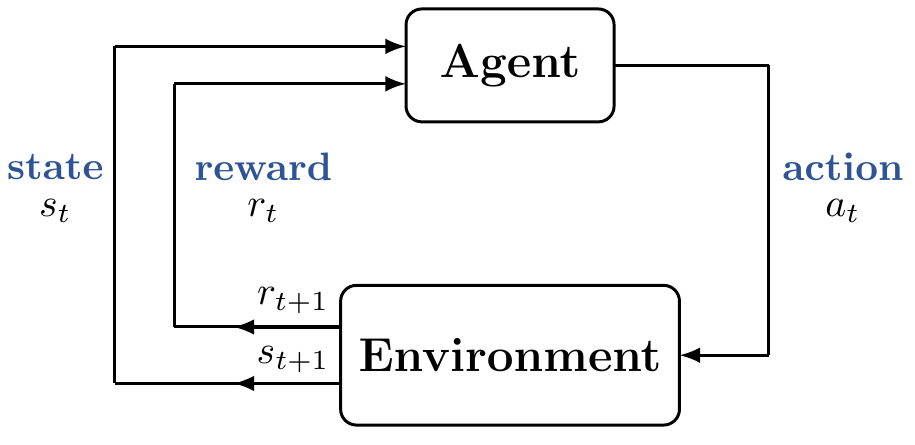
Figure 2. The interaction between an agent and the environment in the framework of reinforcement learning [15]. At a time step t , the agent observes the state s t of the environment and takes an action a t . The environment then transitions to a new state s t + 1 and responds to the agent by returning a reward r t